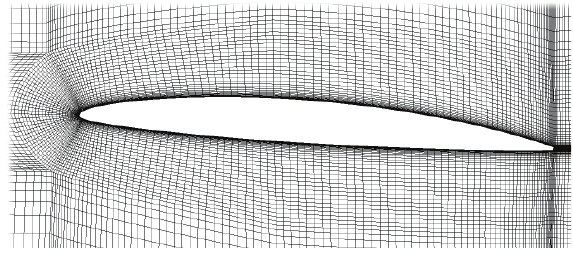
Figure 3: Mesh around the NACA66(MOD)